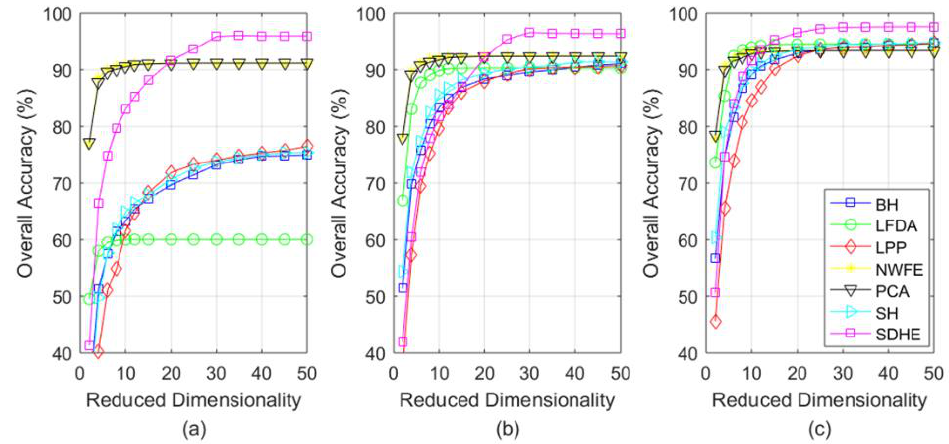
Figure 9. The OA (%) with the change of reduced dimensionality for KSC. ( a ) indicates the training